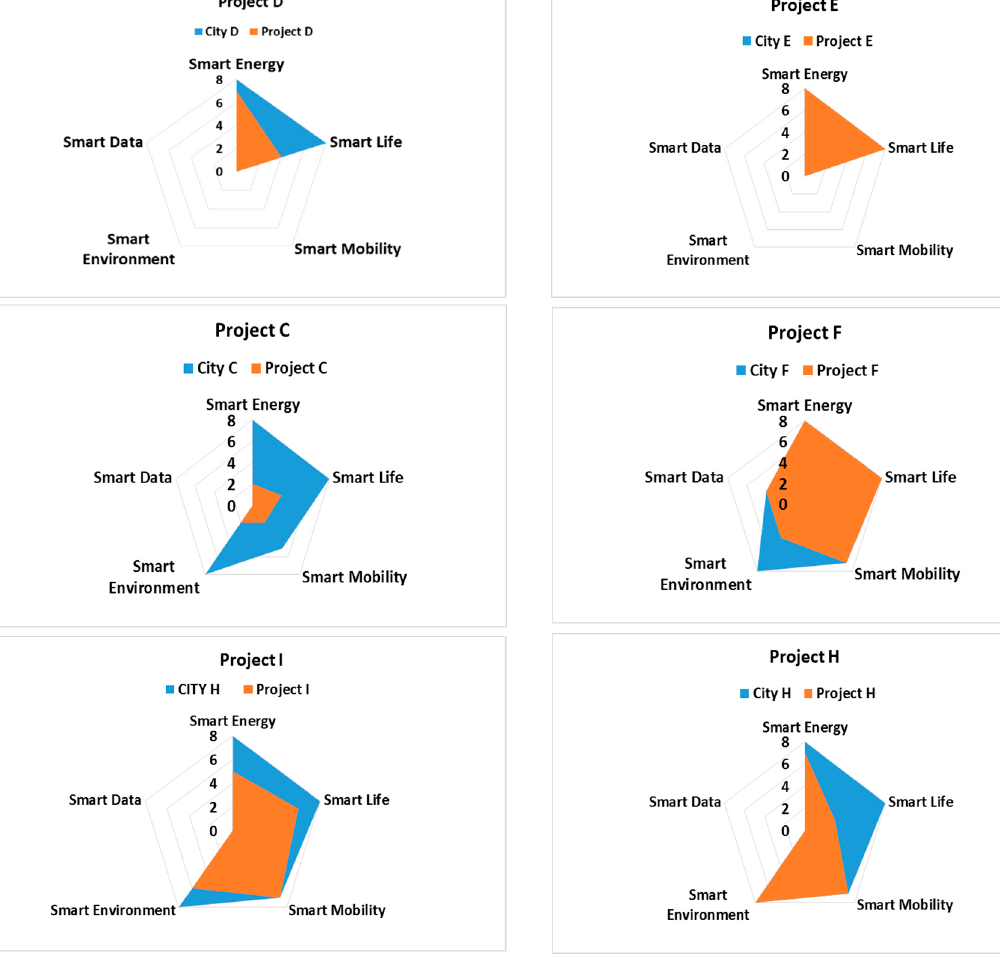
Figure 2. Sectional Analysis of Smart Buildings Integration into Smart Cities.